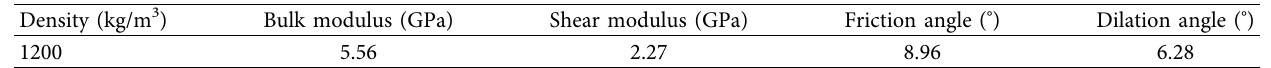
Table 4: Basic properties of the gob material.